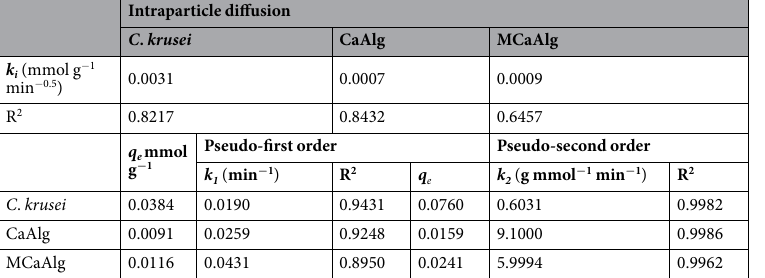
Table 2. Kinetics parameters of C . krusei , CaAlg and MCaAlg upon removal of